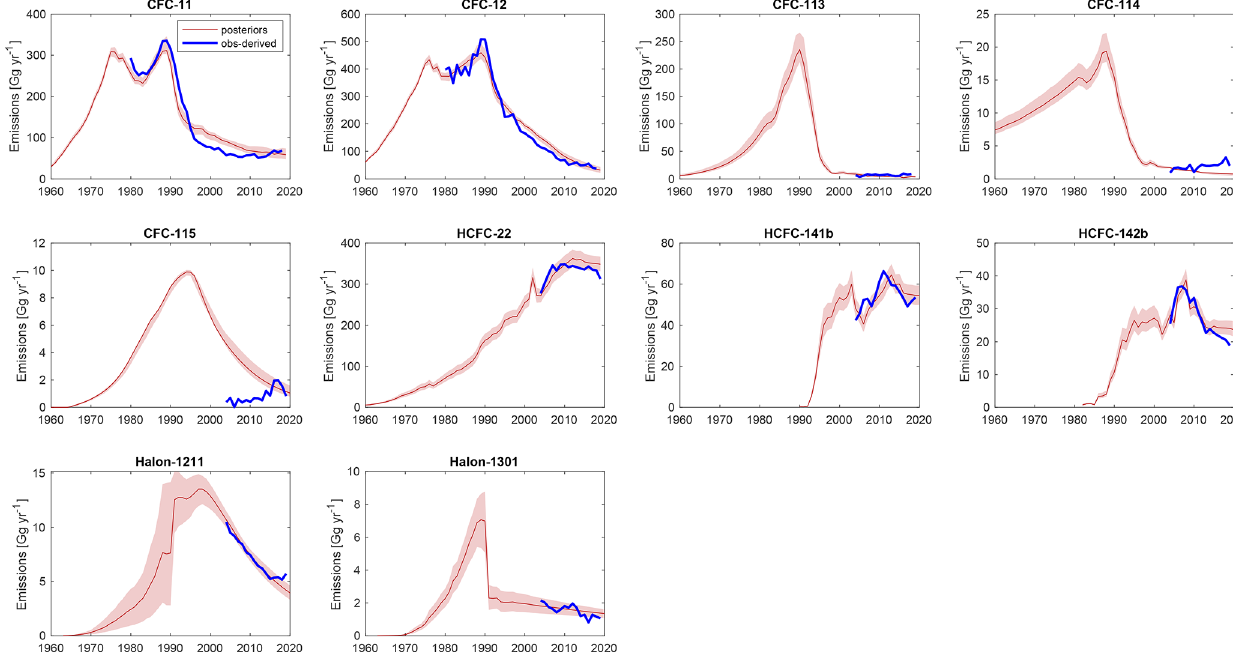
Figure 2. Modeled emissions versus observationally derived emissions. Red lines indicate the posterior median emissions estimate from the Bayesian parameter estimation (BPE), with shaded regions indicating the 90% confidence interval. Blue lines indicate observationally derived emissions assuming the SPARC multimodel time-varying mean